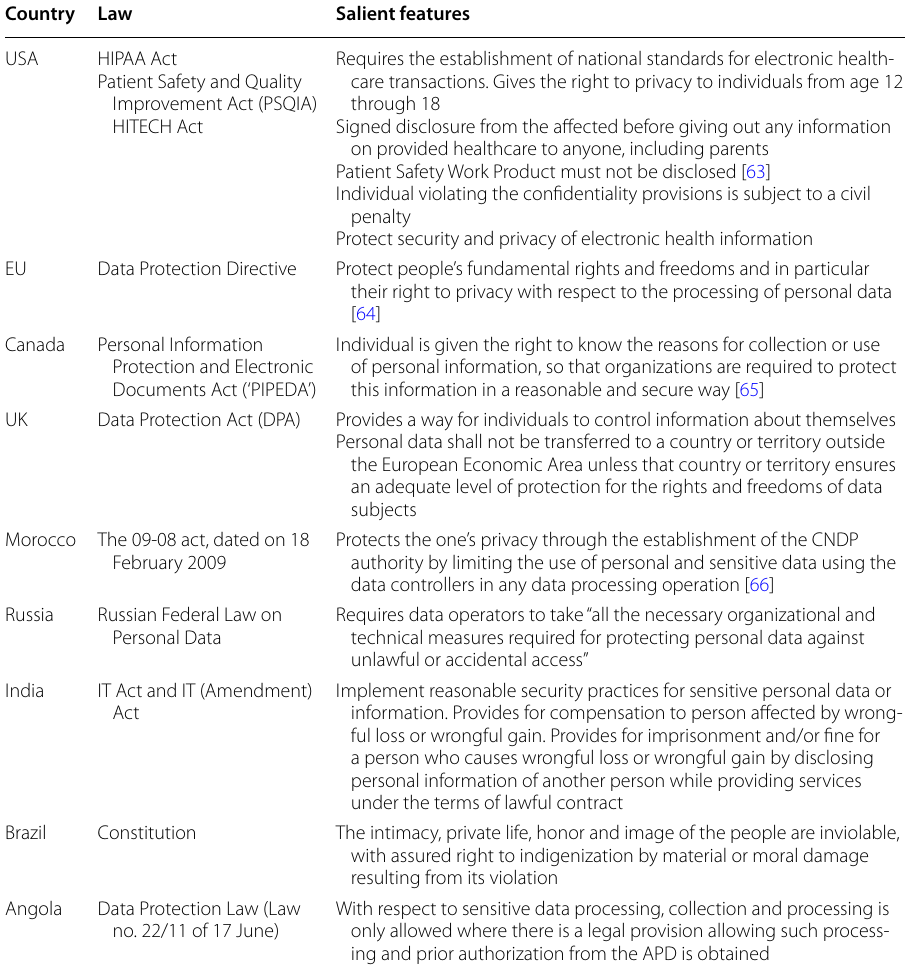
Table 2 Data protection laws in some of the countries Country Law Salient